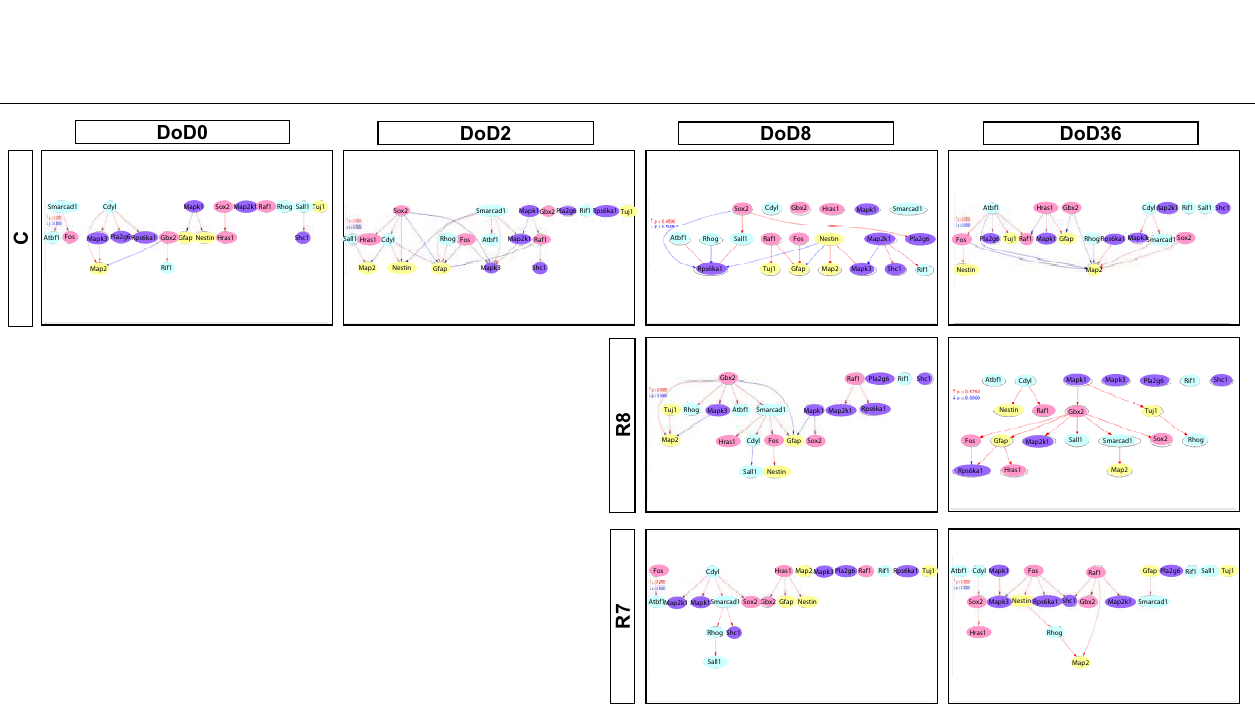
FIGUREA1 | Gene interaction networks of the literature-based gene set (set 1) in mESCs, EB, and NP of neuronal differentiation. The optimized network was generated at p > 0.300. Red indicates that parent genes up-regulate children genes. Blue indicates that parent genes down-regulate children genes.